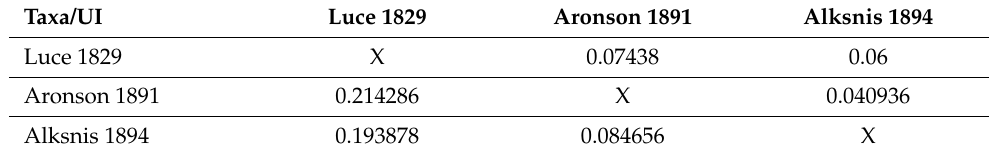
Table 3. Jaccard Indexes (JI) showing the proportional overlap between the authors. Taxa/UI Luce 1829 Aronson 1891 Alksnis 1894 Luce 1829 X 0.07438 0.06 Aronson 1891 0.214286 X 0.040936 Alksnis 1894 0.193878 0.084656